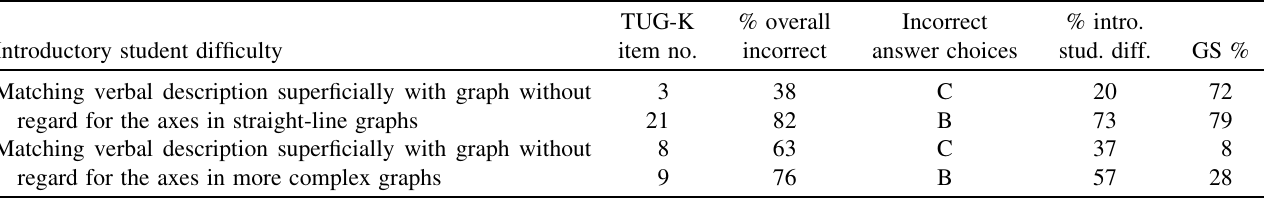
TABLE VI. Introductory student difficulty related to interpreting straight-line and more complex graphs, items on the TUG-K which uncover this difficulty (TUG-K item no.), percentage of introductory students who answer the items incorrectly (% overall incorrect), incorrect answer choices which uncover this difficulty, percentage of introductory students who have this difficulty based on their selection of these answer choices (% intro. stud. diff.), and percentage of graduate students who select these answer choices as the most common incorrect answer choices of introductory students (GS %). For convenience, short descriptions of the questions are given